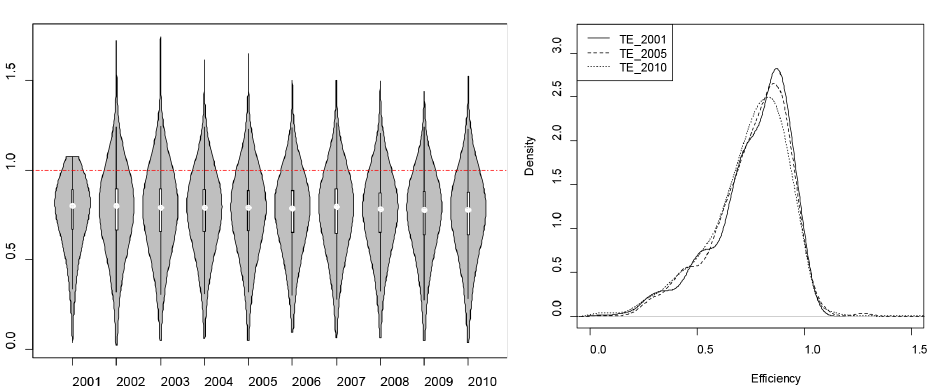
Fig. 1a. Evolution of technical efficiency Fig. 1b. Kernel distribution of